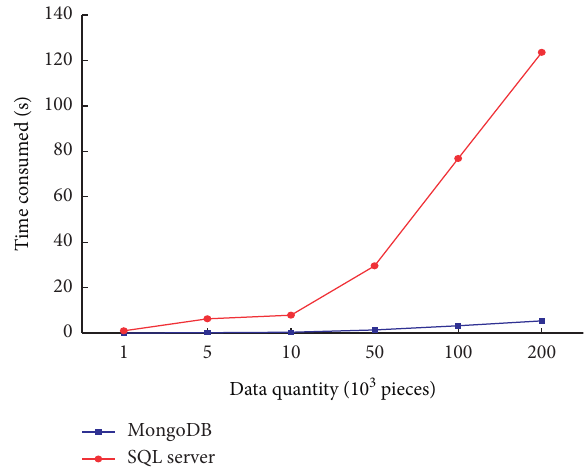
Figure 4: Comparison of the data storage performance of two different database